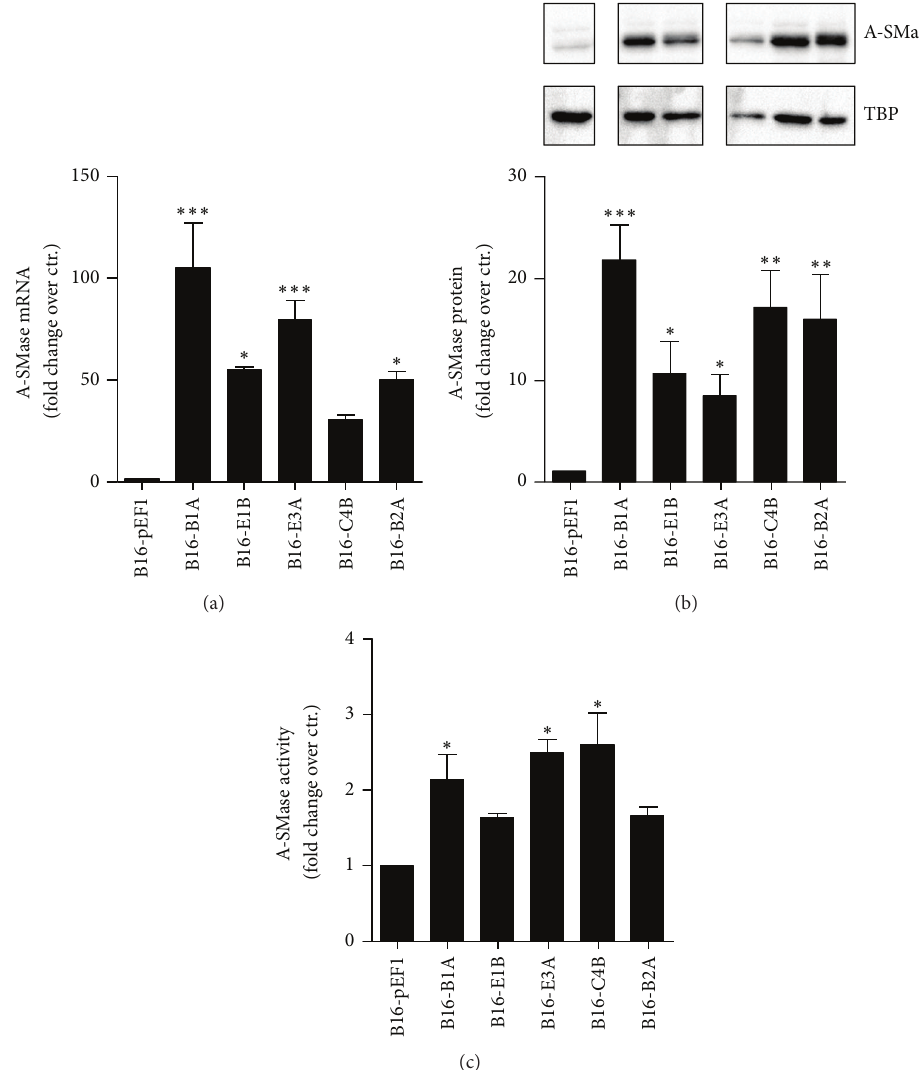
Figure 3: Generation of B16-F1 clones stably expressed A-SMase. Evaluation of A-SMase expression/activity in B16-F1-derived clones overexpressing A-SMase. The B16-pEF1 clone transfected with the empty vector (pEF1) was used as control. (a) qPCR analysis of A-SMase expression. (b) Western blotting analysis of A-SMase. Image is representative of at least three independent experiments. TBP was used as loading control. The histograms represent the densitometric values normalized on TBP. (c) A-SMase activity on cell lysates measured as sphingomyelin hydrolysis at pH 5.5. Values are expressed as fold increases over control ± SEM ( 𝑛 = 3 ). ∗ 𝑃 < 0.05 ; ∗∗ 𝑃 < 0.01 ; ∗∗∗ 𝑃 < 0.001 versus B16-pEF1